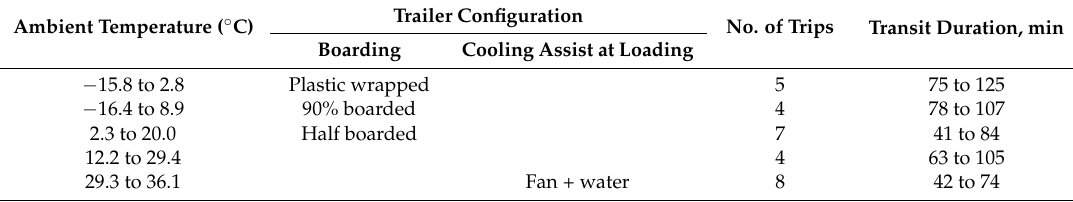
No. of Trips Transit Duration, min